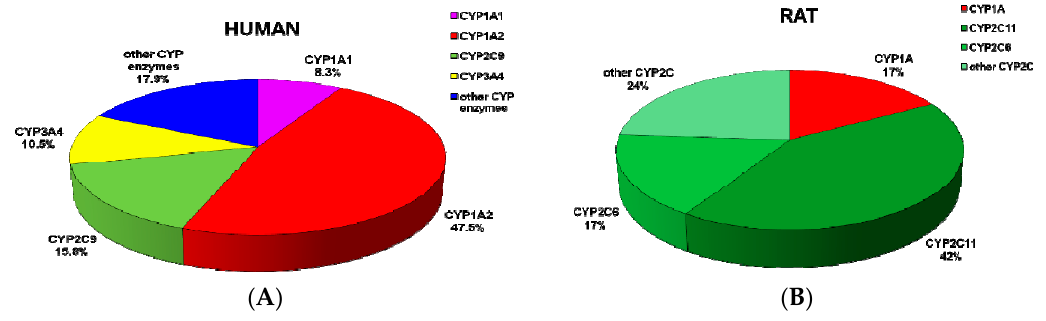
Figure 3. Contributions of CYP enzymes to AAIa formation in human ( A ); and rat livers ( B ).